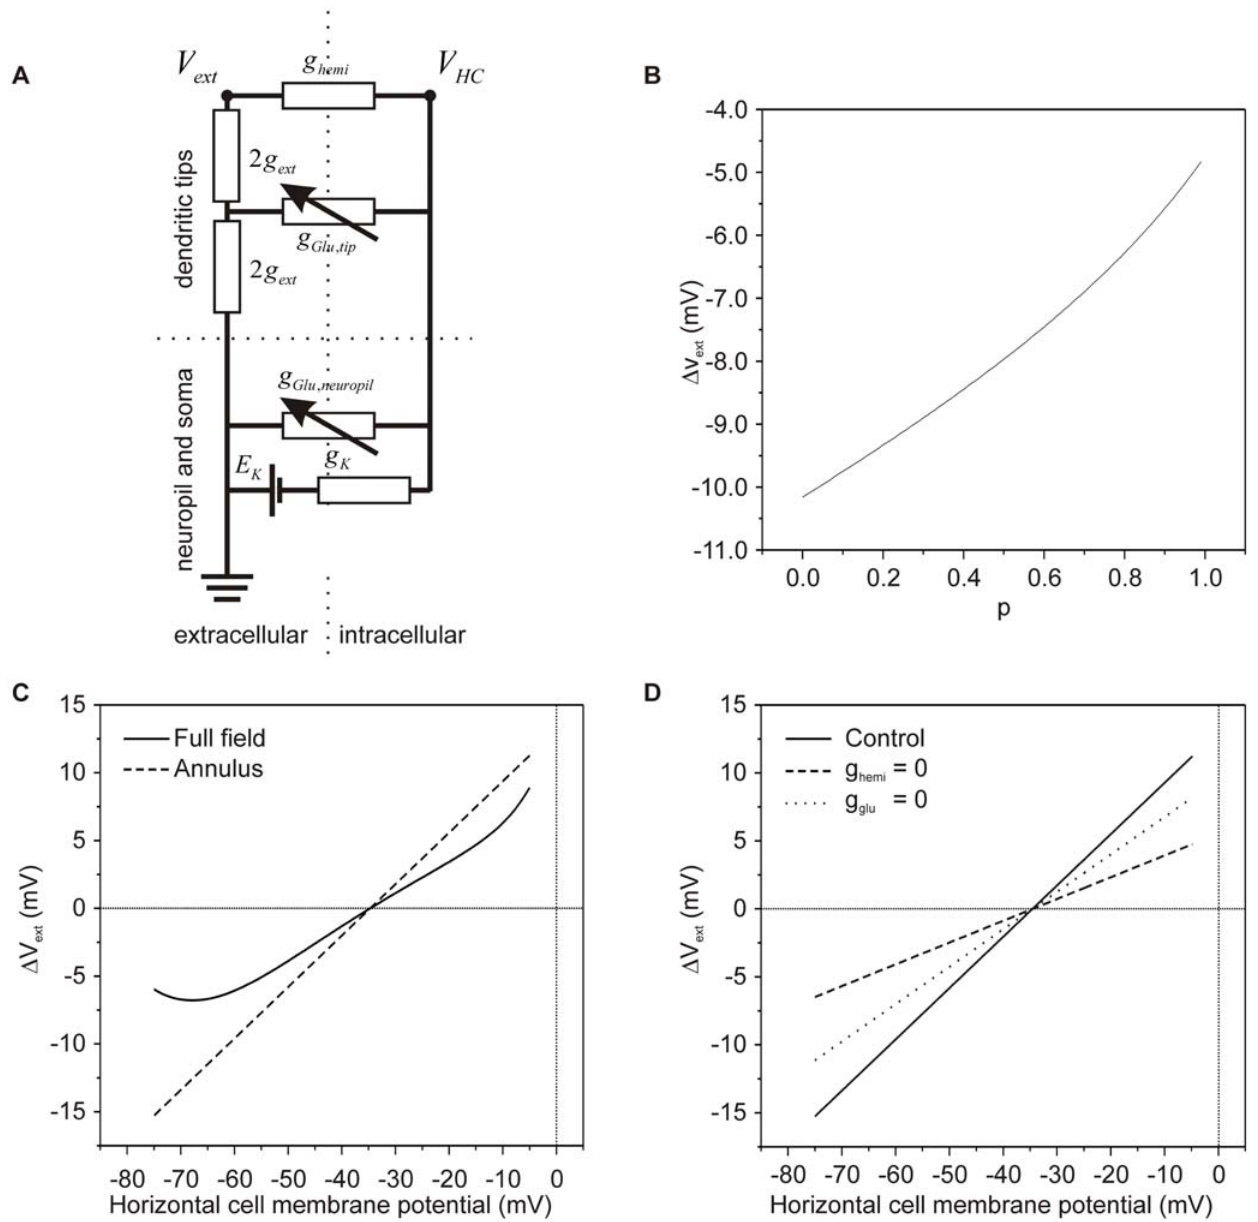
Figure 12. Model for ep[haptic feedback from horizontal cells to cones. A , Network of components essential to model ephaptic feedback from horizontal cells to cones. The ephaptic influence of the horizontal cell onto the cones is through changes in the extracellular potential of the synaptic cleft. V ext is the output of the model and affects the position of the Ca 2 + -current of the cone along the voltage axis and thereby modulates the amount of calcium flowing into the cone. The horizontal cell has two compartments, 1) the neuropil and soma, and 2) the dendritic tips. The neuropil and soma compartment has the following components: E K , reversal potential of combined potassium and leak channels; g K , the combined potassium and leak conductance. g Glu , neuropil , glutamate conductance in the neuropil and soma. The dendritic components are: g ext , the conductance of the extracellular space in the synaptic cleft between cones and horizontal cells; g hemi , the hemichannel conductance, and g Glu , tip , the conductance of the glutamate-gated channels present in the tip of the horizontal cell dendrites. B , The relation between the fraction of glutamate-receptors in the tip of the horizontal cell dendrite ( p ) and the size of the voltage drop in the synaptic cleft when horizontal cells are polarized from their resting membrane potential ( 2 34.7 mV) to 2 71.4 mV. The smaller the fraction of glutamate-gated channels on the tips of the horizontal cells, the larger the horizontal cell polarization-induced voltage drop in the synaptic cleft. C , Voltage drop elicited in the synaptic cleft at the different membrane potentials of horizontal cells when stimulated with a full-field (solid line) or with an annulus (dashed line). When horizontal cells are maximally polarized in the full-field condition, a 6 mV potential drop is elicited; an annular stimulus gives a 15 mV potential drop. D , The relation between the horizontal cell membrane potential and the change in potential deep in the synaptic cleft for annular stimulation (solid line) and in a condition when all hemichannels are closed ( g hemi ~ 0 ) (dashed line) and when all glutamate gated channels are closed ( g Glu ~ 0 ) (dotted line). These simulations show that about 40% of the feedback response remains when hemichannels are closed, illustrating that glutamate gated channels contribute about 40% to the ephaptic feedback mechanism.